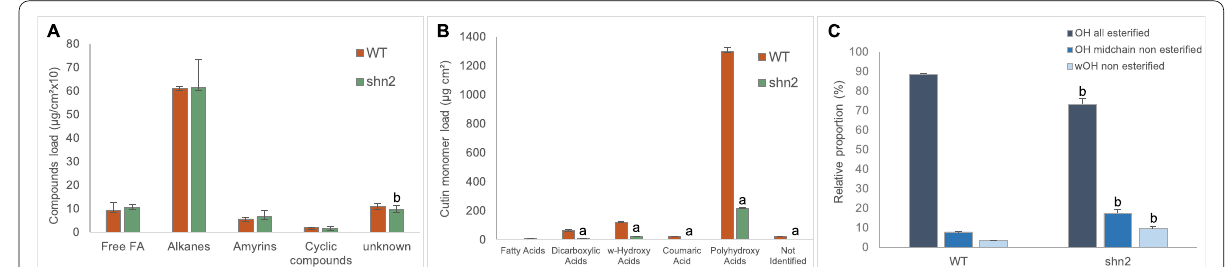
Fig. 3 Fruit from the shn2 mutant shows severe cutin-deficiency. A Wax load and composition of the fruit cuticle from wild-type (WT) and shn2 plants. Values (µg/cm 2 10) are mean SD ( n 3). B Cutin load and composition of fruit cuticle from wild-type (WT) and shn2 plants. Values × ± = (µg/cm 2 ) are mean SD ( n 3). C Esterification degree of the 9(10),16-dihydroxyhexadecanoic acid OH groups of tomato fruit cutin. Values are ± = mean SD ( n 3). a, P < 0.01; b, P < 0.05 (Student’s t ± =